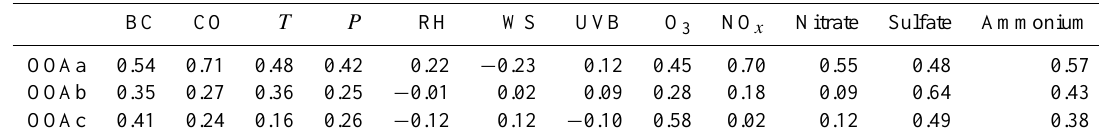
Figure 7. Size distribution of (a) organics, (b) nitrate, (c) sulfate and (d) ammonium in PBL, TR and FT samples. Log-normal fits are reported as black lines. Table 2. Pearson correlation coefficients ( R ) between the time series of the three PMF factors and several gas-phase and particle tracers measured at Mt. Cimone. T = air temperature, P = atmospheric pressure, RH = relative humidity, WS = wind speed, UVB = UVB radiation